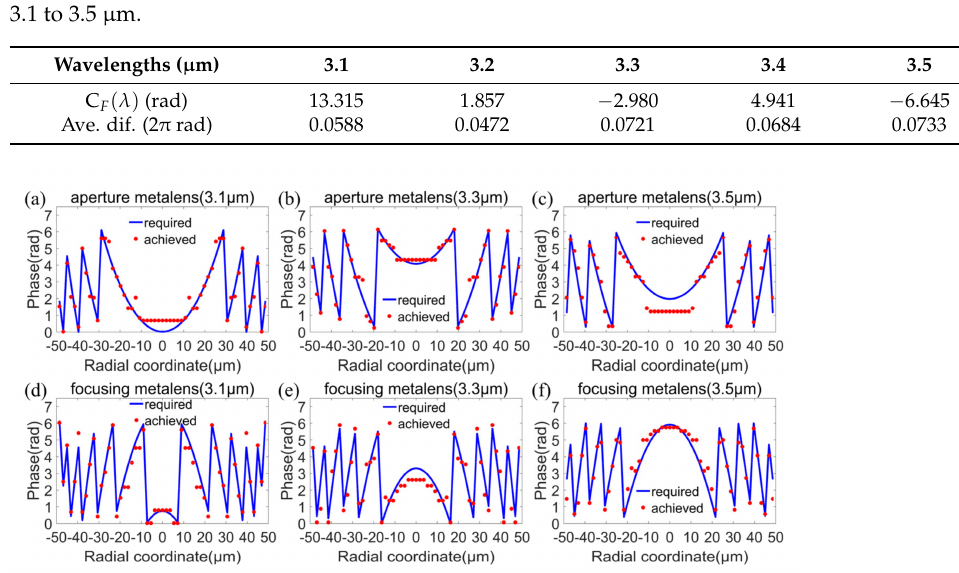
Figure 5. Comparisons of the required phase profiles (blue lines) and the phase profiles induced by the designed aperture metalens and focusing metalens (red dots) at wavelengths 3.1 µ m ( a , d ), 3.3 µ m ( b , e ), and 3.5 µ m ( c , f ),